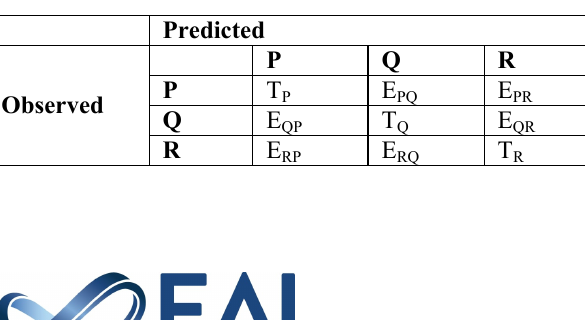
Table 2. Confusion Matrix for a Three Class